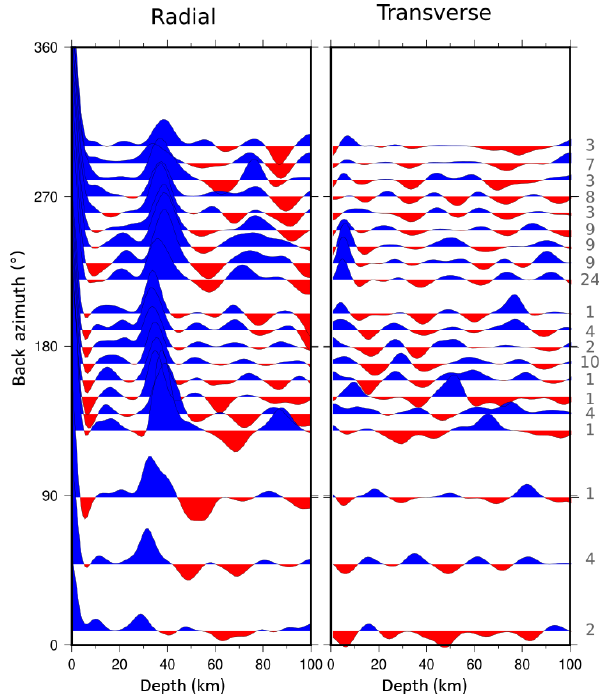
Figure 4. Example of stacked receiver functions represented by back-azimuth bins of 10 ◦ at station PFBR. Grey numbers corre- spond to the number of stacked receiver